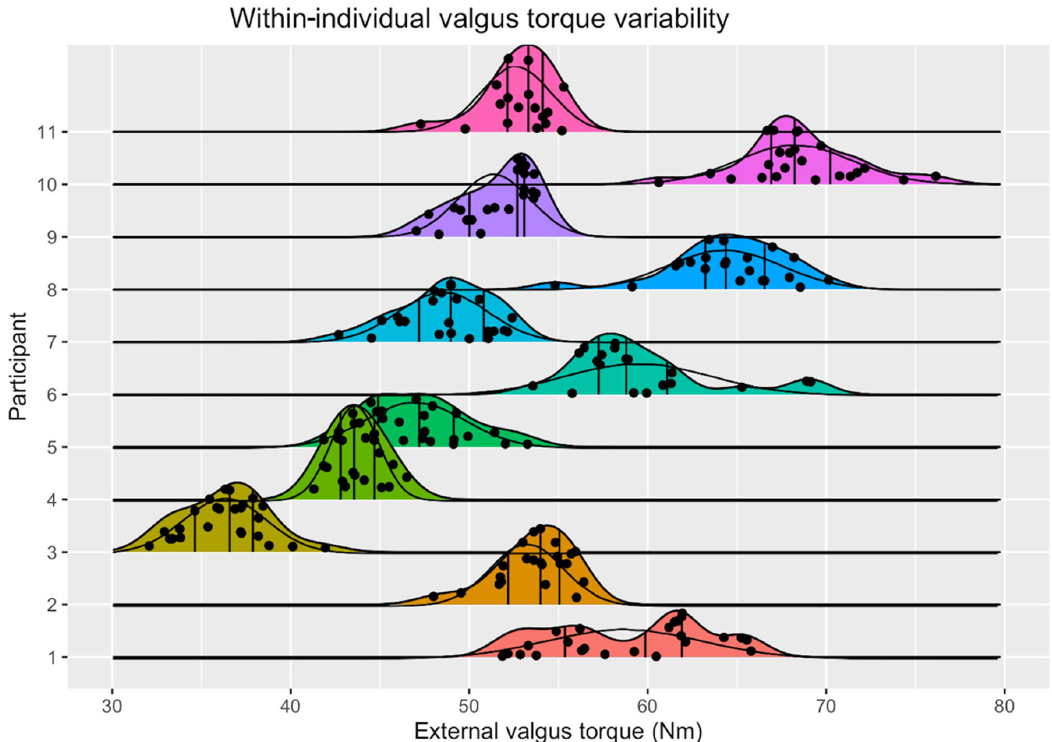
Figure 1. Density plots and matching normal distributions of the within ‐ individual variability in external elbow valgus torque. The participants are shown on the y ‐ axis and the external elbow valgus torque on the x ‐ axis. Each color represents a participant. The dots show the original data of each external valgus torque of a single pitch. The height of the dots is randomly jittered in the density plot. The three vertical solid lines inside the density plots show the 25th, 50th, and 75th percentile of the distribution, respectively. The thin line inside the density plot shows the modeled normal distribution based on the distribution’s mean and standard deviation.